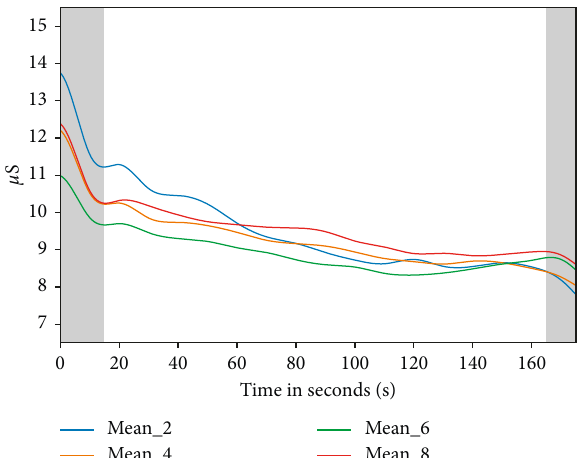
Figure 10: Plot of graphs of SCL averaged over all subjects for each density in the first 15seconds.